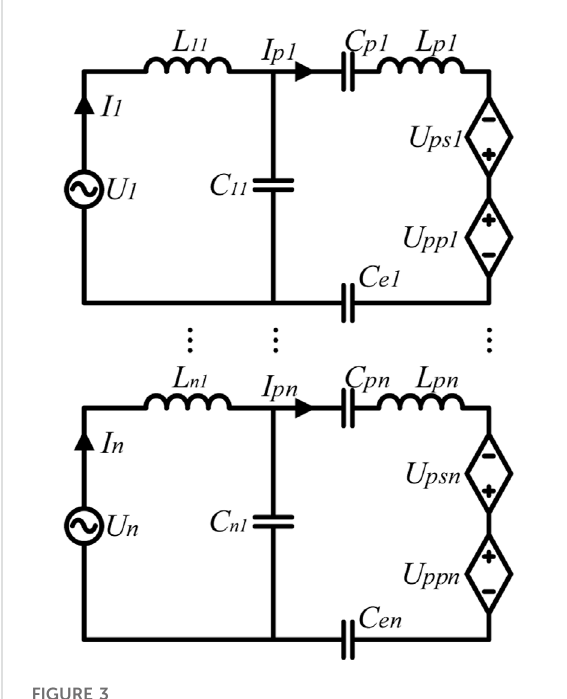
FIGURE 3 Equivalent Circuit of MTMR WPT System with Capacitance Compensation.Inthispicture,therearenpairsoftransceivercoils.